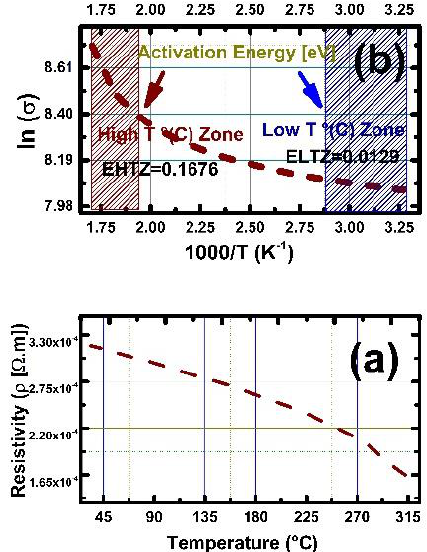
Figure 8. ( a ) Dynamic resistivity of 20 nm thick PEALD SnO 2 as a function of temperature under atmospheric conditions. ( b ) Electrical conductivity as a function of reciprocal of temperature (1/T) for PEALD deposited SnO 2 thin